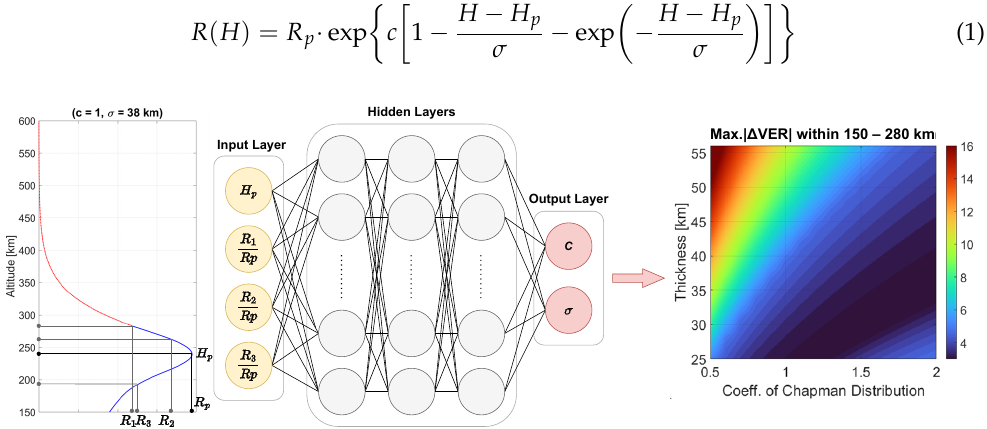
Figure 2. Illustration of deep learning training method. The left panel shows a profile of intensity as an example, while the middle panel demonstrates the input, hidden, and output layers of the artificial neural network. The partial Chapman distribution of the type coefficient ( c ) as 1, and thickness ( σ ) as 38 km is in red, and the blue part indicates the observed Rayleigh. The right diagram shows an OSSE result, the maximum absolute difference of the model-derived VER (considered as ground truth data in OSSE), and the Abel retrieved VER in this case within 150–280 km with different sets of ( c , σ ). The altitude of the peak intensity ( R p ) is denoted as H p , and the ratio of intensities at 290 km ( R 1 / R p ), 280 km ( R 2 / R p ), and 180 km ( R 3 / R p ) are selected as inputs. There are 3 hidden layers, and the outputs are c and σ